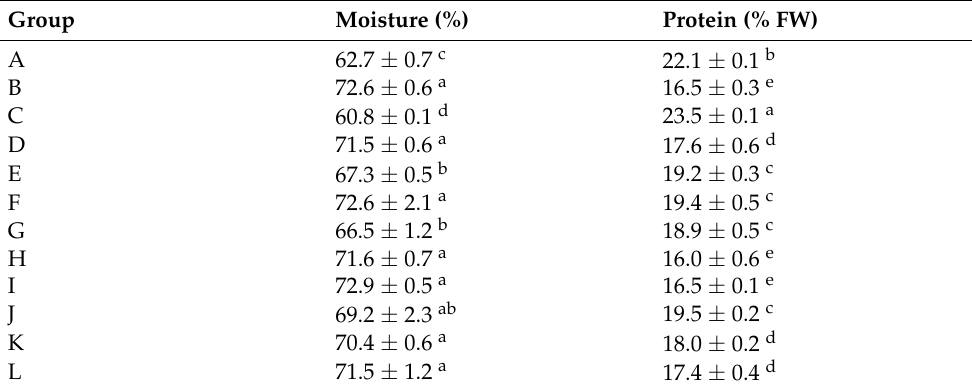
Table 3. Moisture and protein content of living mealworm larvae on a fresh weight (FW) basis (%). Values are given as mean ± standard deviation, n = 3.